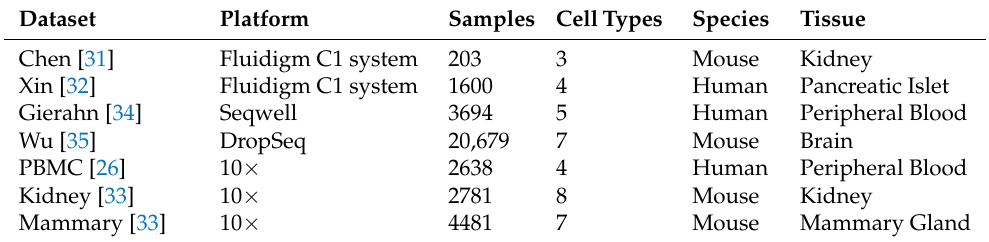
Table 1. Summary of